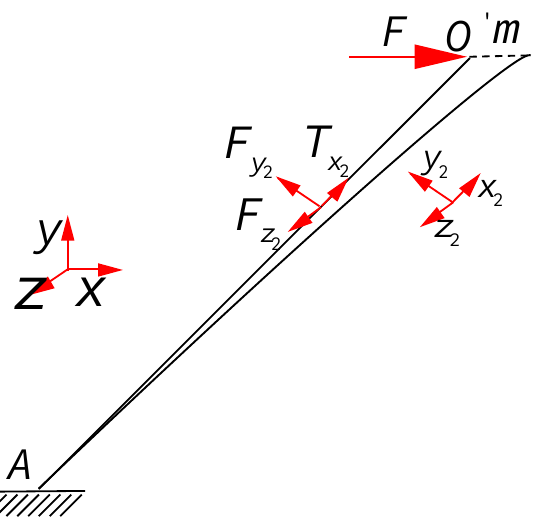
Figure 4. Typical element deformation mode under constraint boundary.